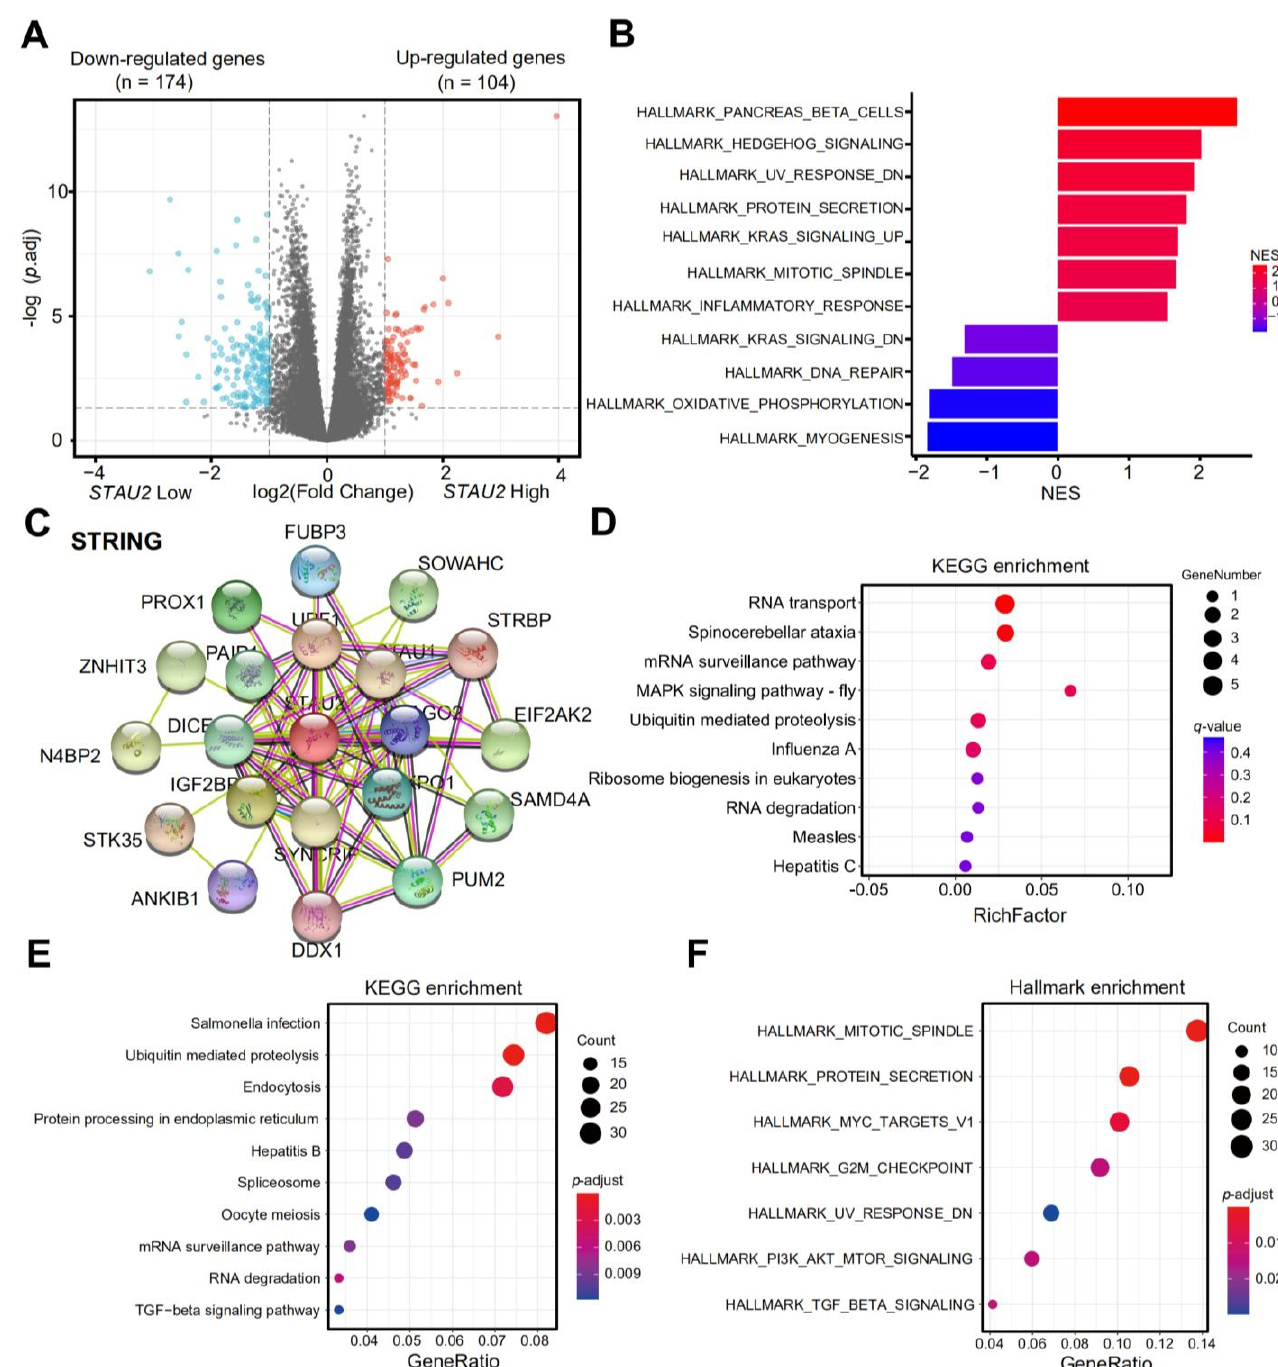
Figure 6. The function analysis of STAU2 and its-related genes . ( A ) Volcano plots show significantly differentially expressed genes between high and low expressing subpopulations of STAU2 in PAAD. ( B ) GSEA enrichment of the STAU2 correlated genes. ( C ) The PPI analysis of STAU2 (STRING). ( D ) KEGG enrichment of the PPI genes. ( E ) Dot plots showing enriched KEGG pathways of STAU2 -related genes. ( F ) Dot plots showing hallmark pathway enrichment results of STAU2 -related genes.